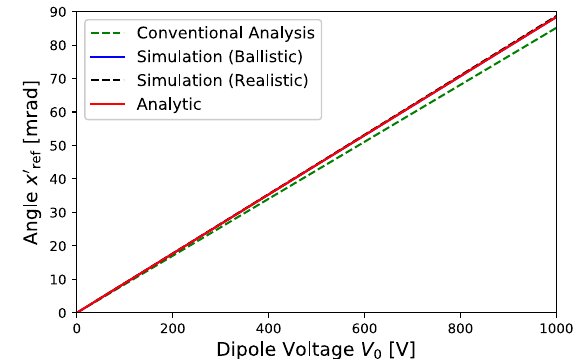
FIG. 5. Voltage-to-angle relation for the selected beam. The red curve (analytic) overlays the blue curve (ballistic